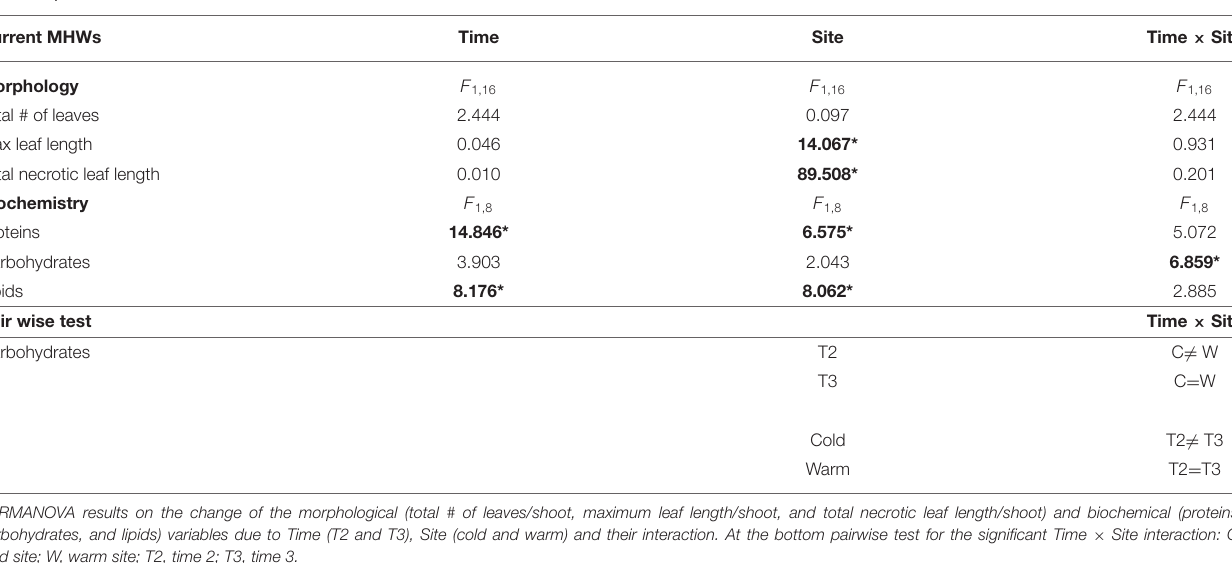
TABLE 3 | Current MHWs.